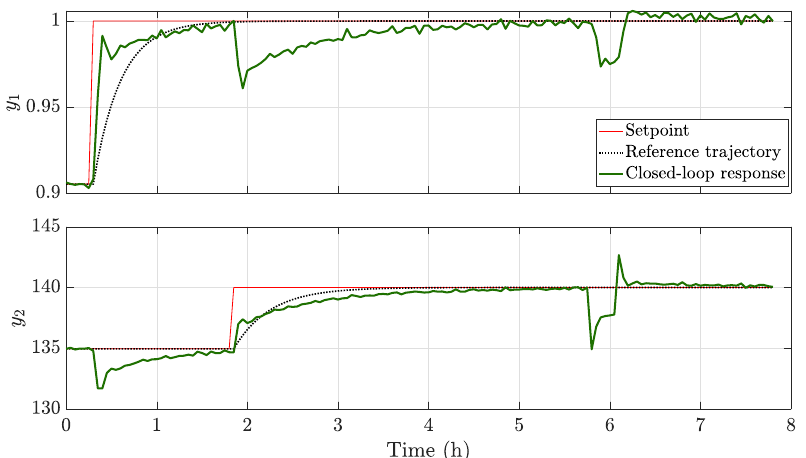
Figure 22. Case 2—Response of the outputs of the Van de Vusse reactor to setpoint changes and disturbance